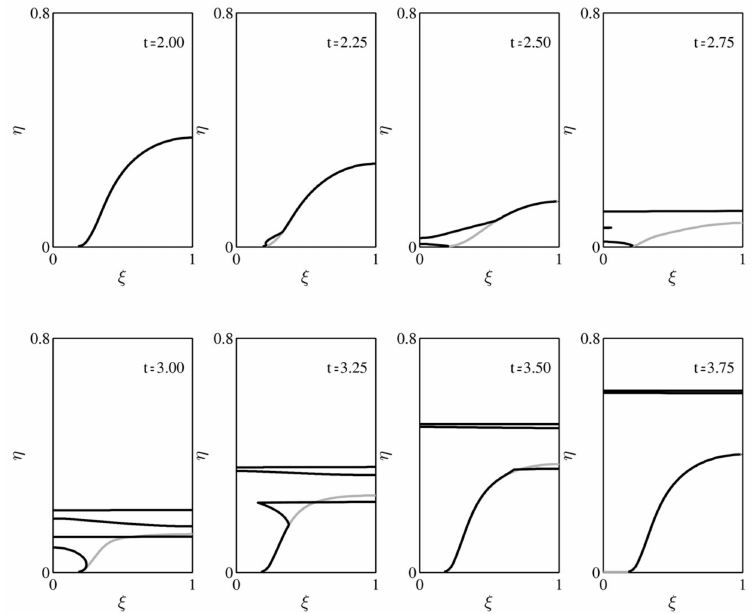
Figure 4. Comparison between the evolution of spray diffusion flame fronts with and without droplet grouping induced by the host gas standing wave flow field accounted for; Key: Solid black lines—with grouping, gray lines—without